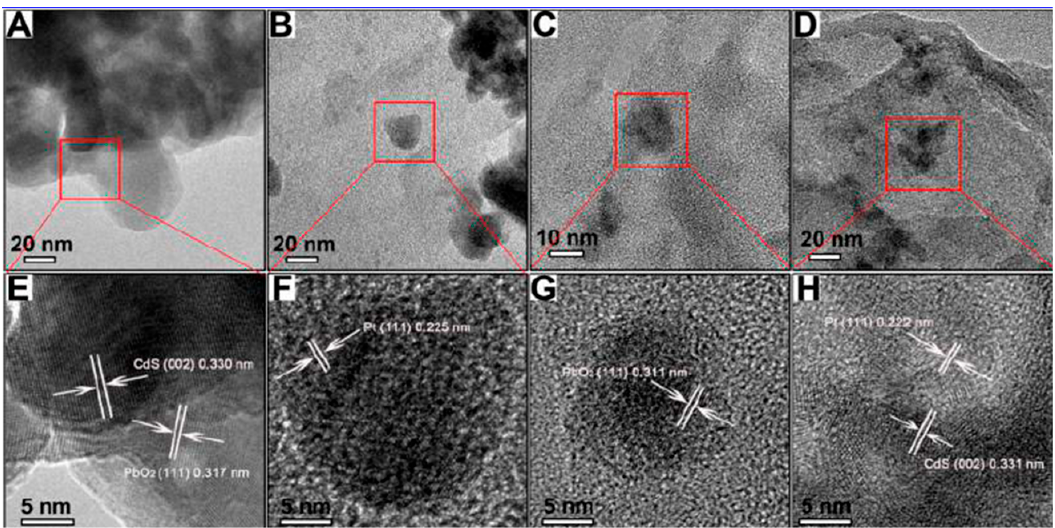
Figure 8. Charge transfer route of chemical deposition g-C 3 N 4 /CdS-10% and photodeposition g-C 3 N 4 /CdS-25. TEM images of g-C 3 N 4 /CdS-10% ( A , B , E , F ) and g-C 3 N 4 /CdS-25 ( C , D , G,H ) photodeposited with PbO 2 nanoparticles (A,E,C,G) and Pt (B,F,D,H) nanoparticles. (E − H) give the corresponding high-resolution TEM images, respectively. Reprinted from reference [68]. Copyright